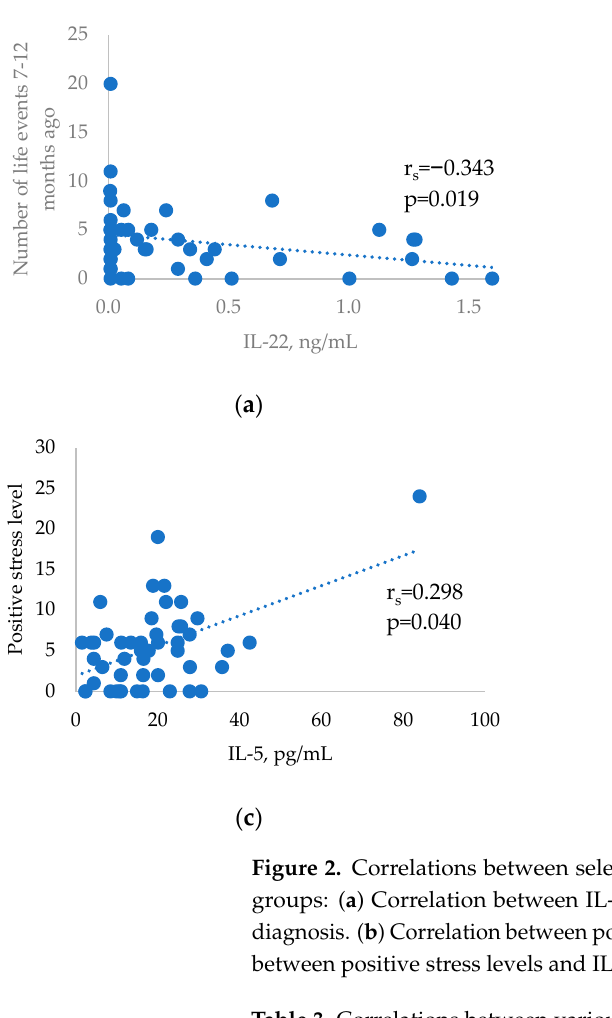
Table 3. Correlations between various stress parameters and TPO-Ab and Tg-Ab.